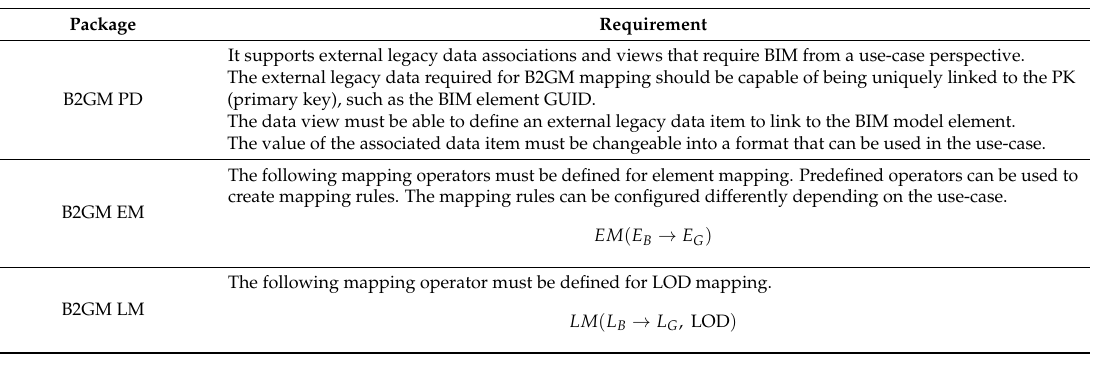
Table 4. B2GM package